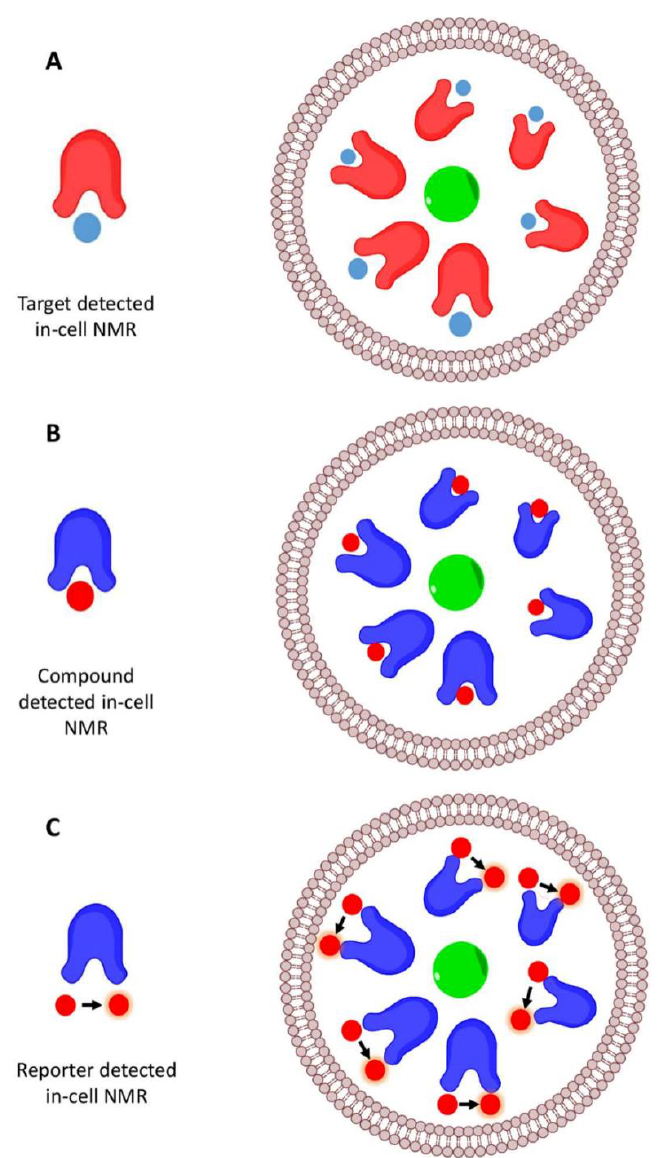
Figure 13. Representation of different in-cell NMR techniques. ( A ) Target-detected in-cell NMR, ( B ) compound-detected in-cell NMR, ( C ) Reporter-detected in-cell NMR. The red color is the isotopically labeled component of the system. Adapted with permission from [409].